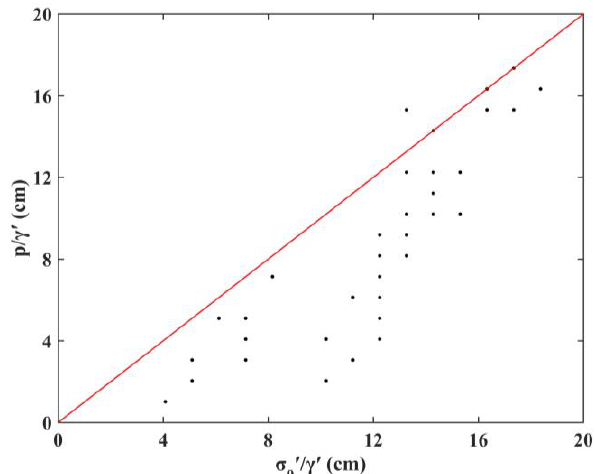
Figure 5. Measured maximum excess pore pressure, P max , plotted against the calculated initial mean normal effective stress using Equation (2) in each test.